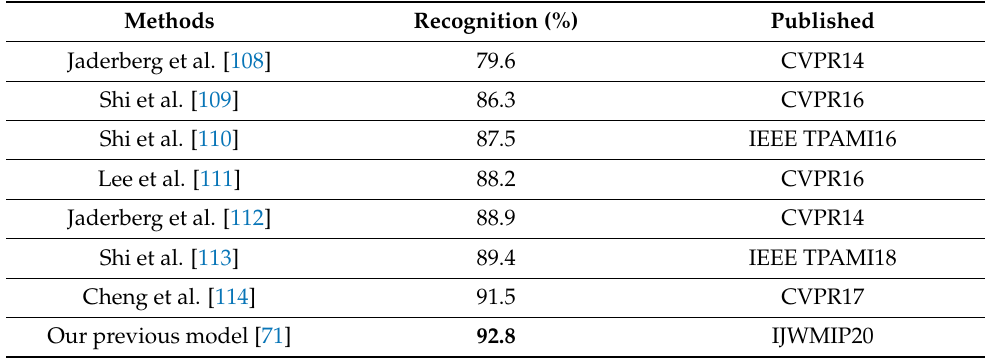
Table 7. The performance comparison of our previous text recognition model with other state-of-the- art models on ExDark datasets. The best results are marked in